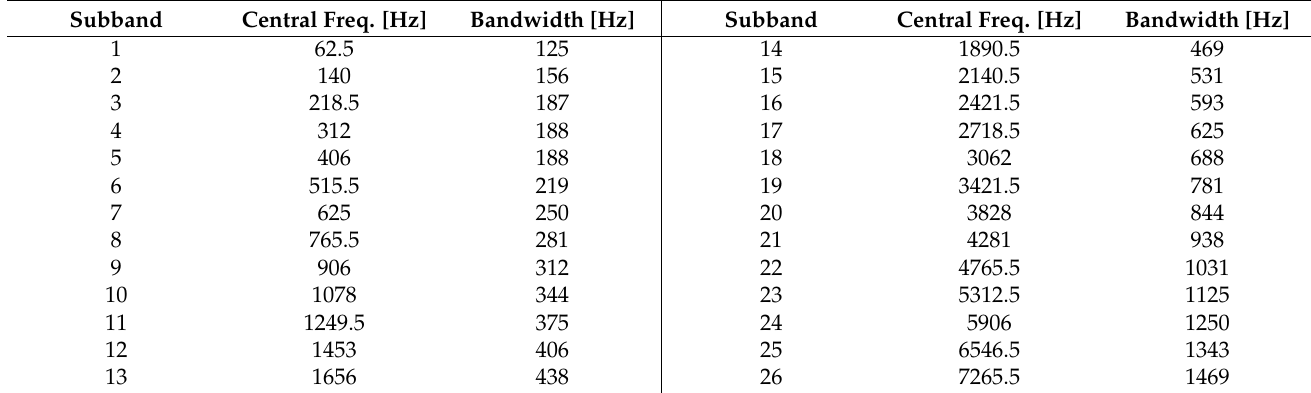
Table 8. Central frequencies and bandwidths for the 26-filter Mel-spaced Gabor